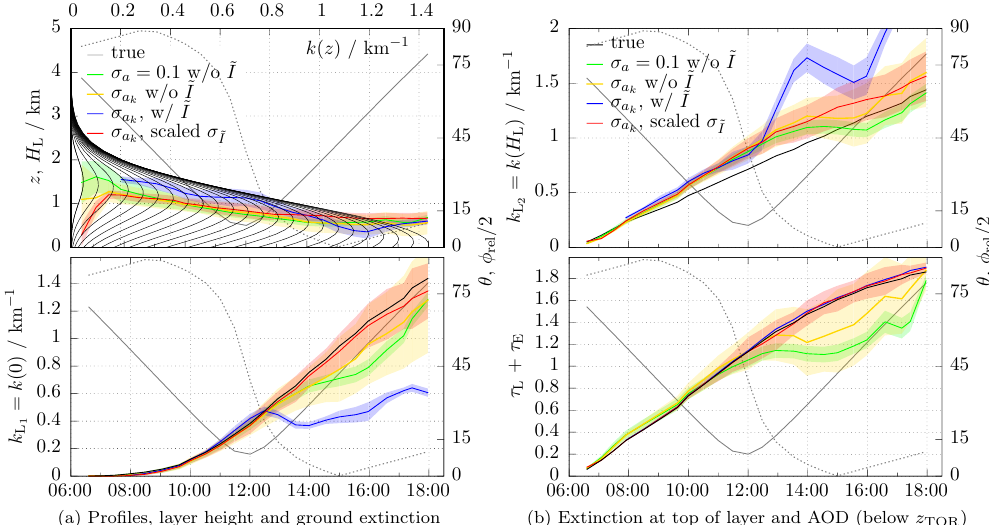
· 1km, k L · 1km, τ L , τ E ) T for the extinction profiles varying in time as shown in (a) (top panel) and different Fig. 16. Retrieval of x =( k L 1 2 choices of the fit quantities, the regularisation parameter and weights for ˜ I . (a) (top panel) “Layer height” H L =2 τ L /(k L ground extinction k L . (b) (top panel) Extinction k L at height H L , bottom panel: AOD τ = τ L + τ E . As in previous figures, lines represent 1 2 averages, and shaded areas standard deviations for 100 MC runs. The maximum number (100) of valid retrievals is reached except for the first three profiles retrieved with ˜ I included explicitly into the fit.